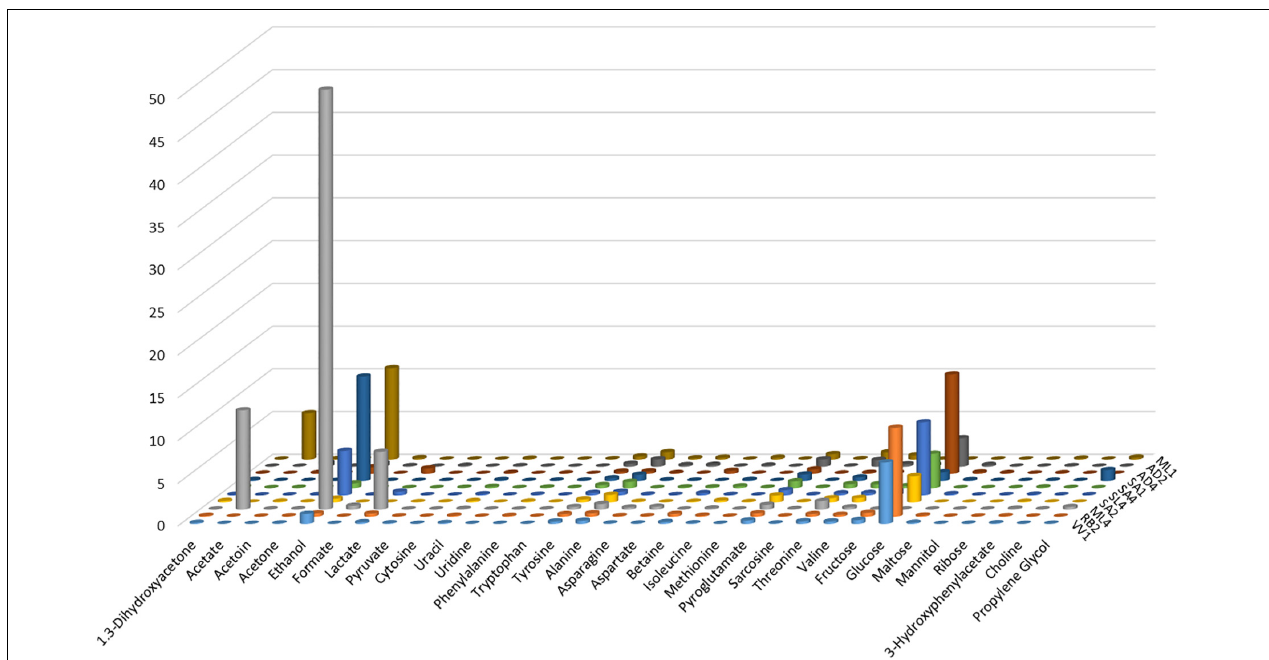
FIGURE 3 | Graphical representation of the metabolite quantities (reported in Table 3 ) founded in the cell-free supernatants produced by the studied Lactobacillus strains grown in MRS with